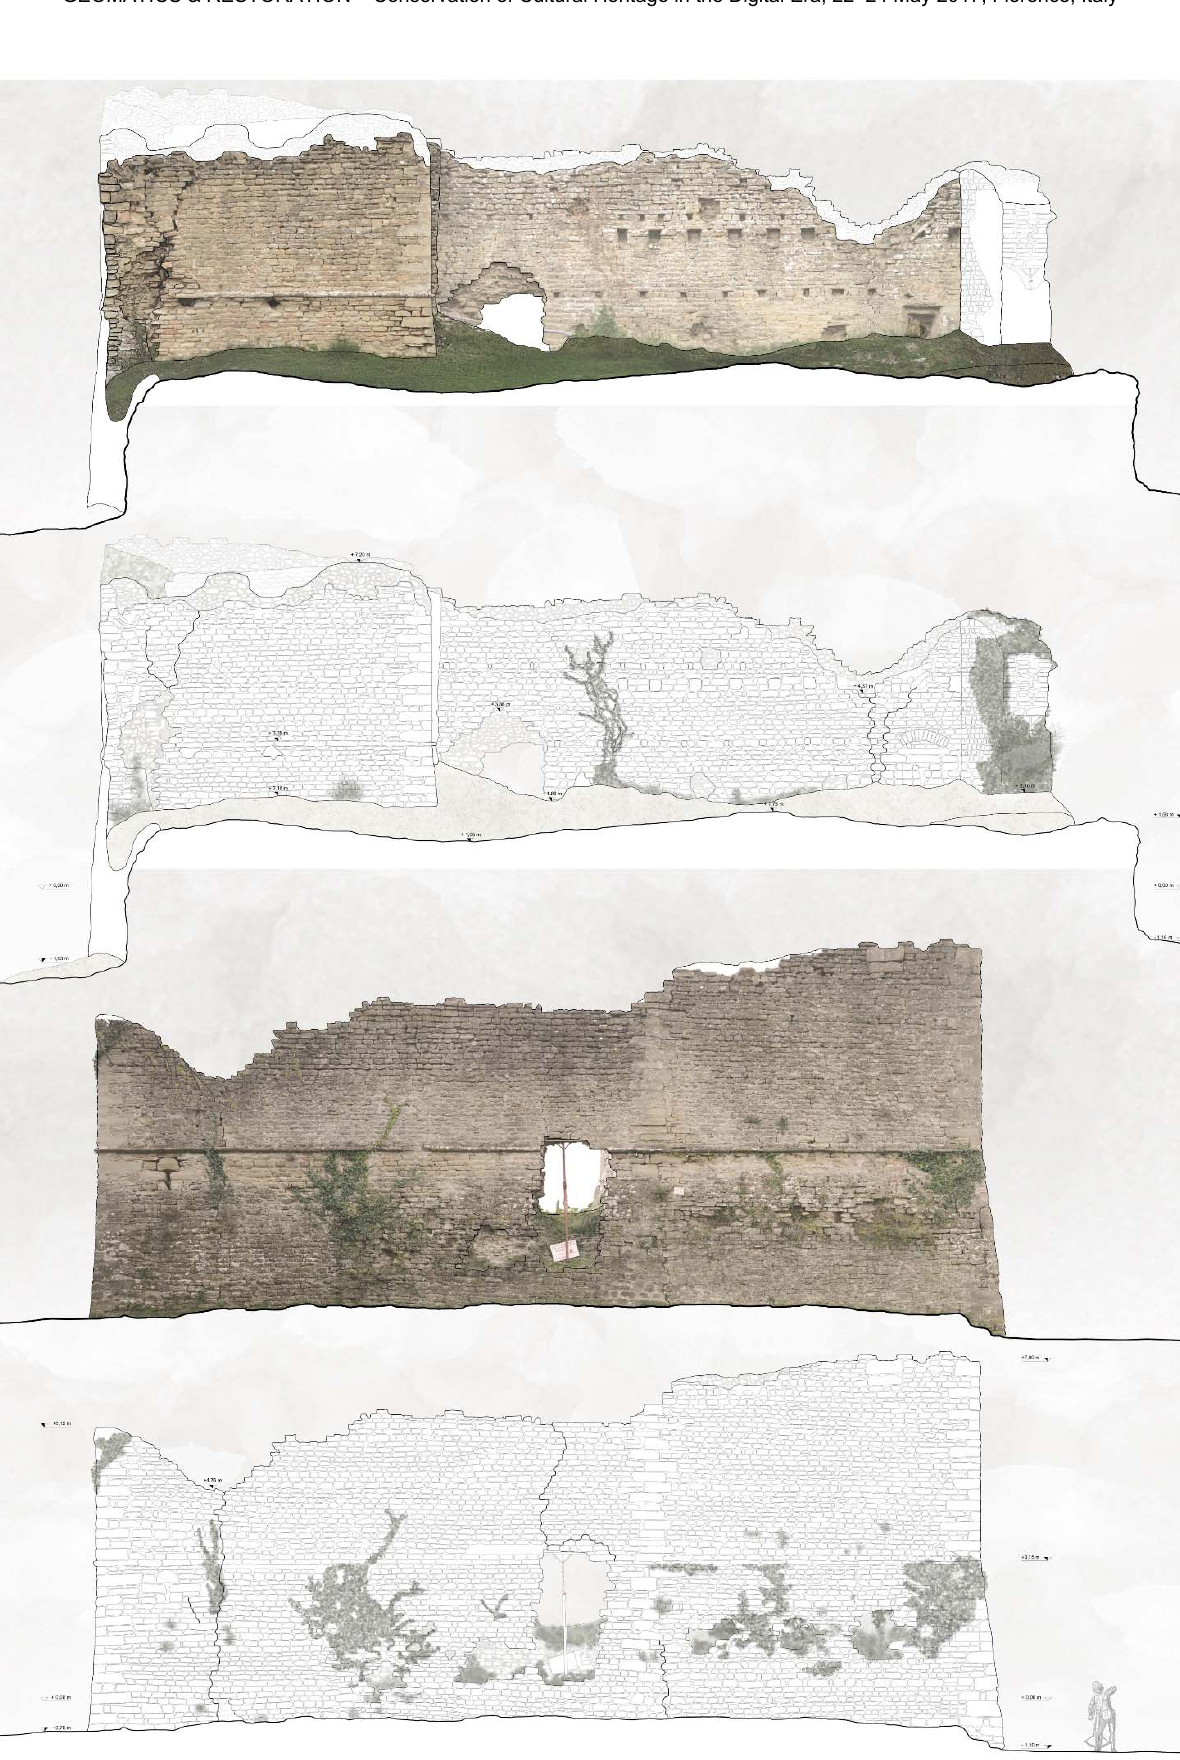
Figure 1. Cantagallo, photogrammetry and elevations NE (surveyors M. Morra, S.